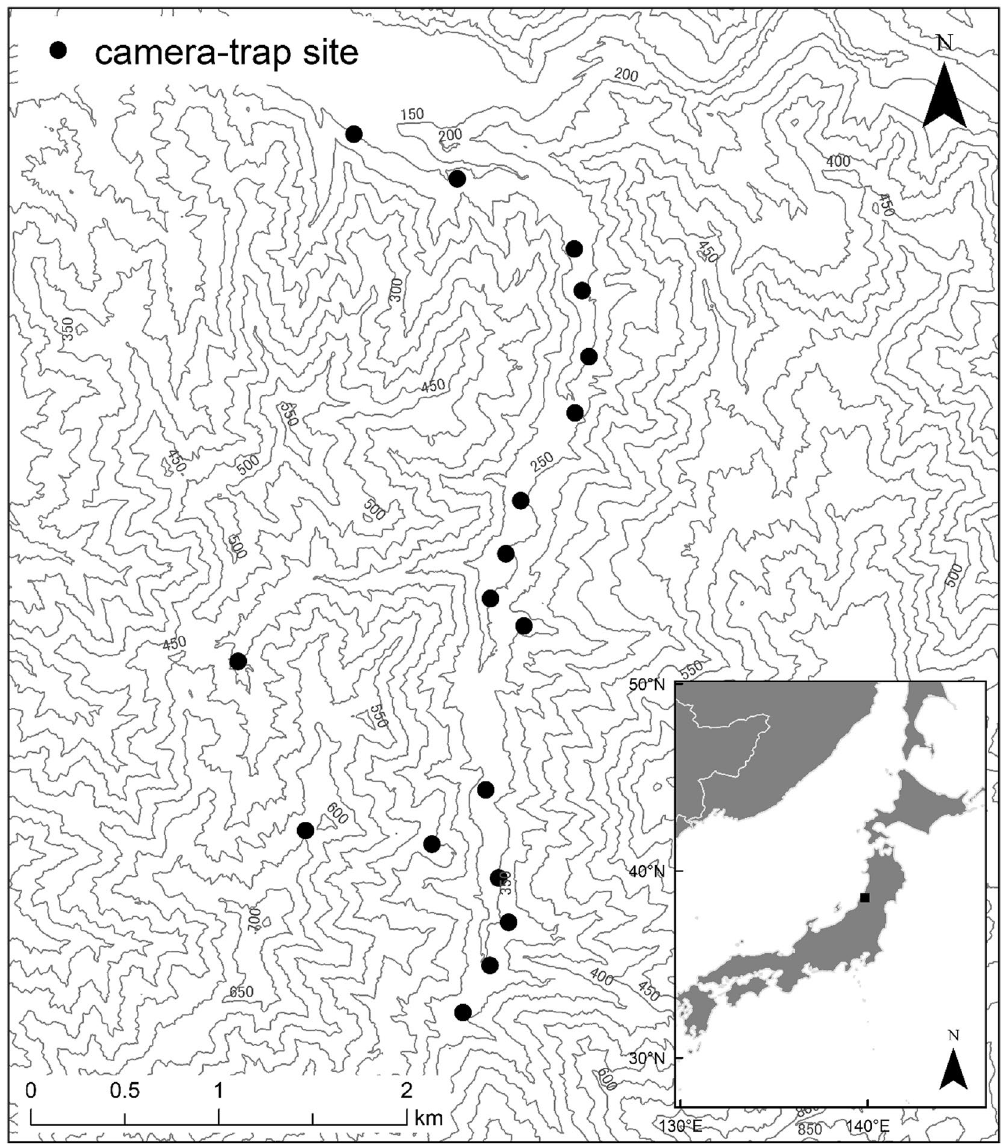
org (http:// thema ticma pping. org/). Contour lines were created using a 5 m digital elevation model from Fundamental Geospatial Data by Geospatial Information Authority of Japan (https:// www. gsi. go. jp/ kiban/ index.